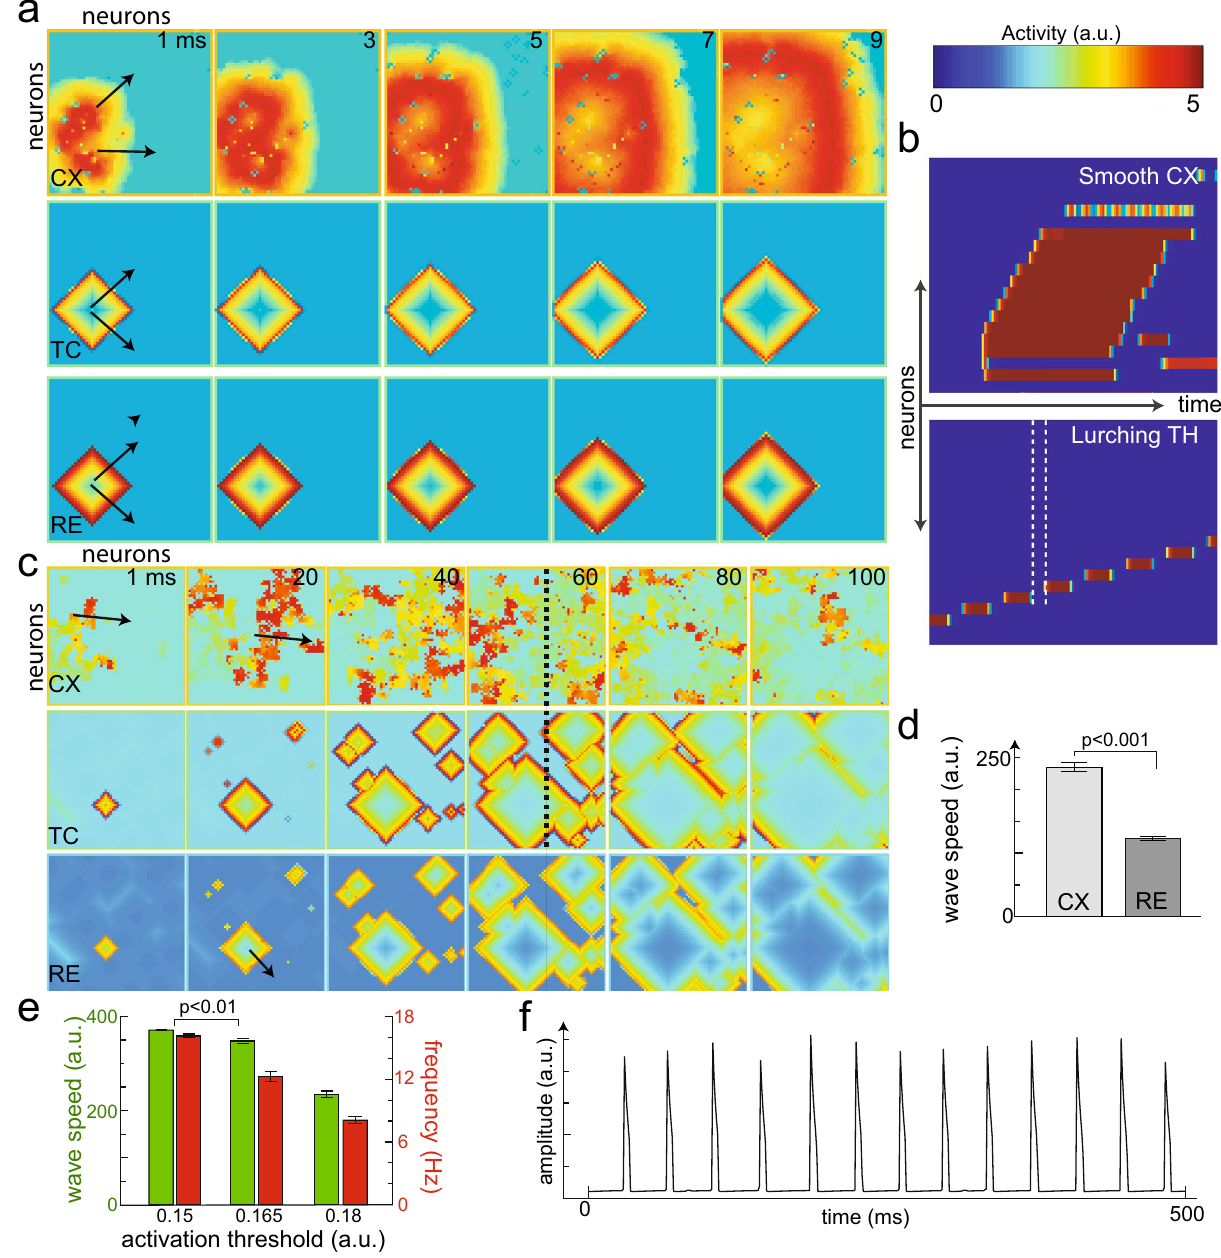
Figure 2. Thalamocortical model and simulated traveling waves. ( a ) Traveling waves produced by the model operated in an open loop (i.e., without CX RE connection, 99% excitatory cortical neurons). Each square → shows the 60 60 array layout of neurons, and colors indicate the level of activity observed. Dynamic traveling × wave patterns are shown (assuming a dense intracortical connectivity); arrows indicate wave directions. Color bar show the scale of neuronal activity (a.u.). ( b ) One-dimensional (1D) projection of the traveling waves to indicate the different wave dynamics between the thalamus and the cortex. The gap between the white dashed lines in the thalamus shows the lurching pattern as the wave is staggered in time; in contrast, the cortical wave is smooth. ( c ) Same layout as a. Computational model operated in a closed loop (with 1% CX TH connections → and 80% excitatory neurons) results in oscillations with random wave directions. The black dashed line denotes the region from which the 1D project in b was taken. ( d ) The average cortical wave speed was significantly faster than the thalamic wave speed ( p < 0.0001 from five simulations, Student’s t test). Error bar represents standard error of mean (SEM). ( e ) Bar graphs showing how traveling wave speed and frequency is altered with system threshold (parameter d_ 4 cortical gating equation in “Methods”). p values were computed from 5 simulations (Student’s t test). ( f ) Time oscillations produced by the cortex of around 15 Hz